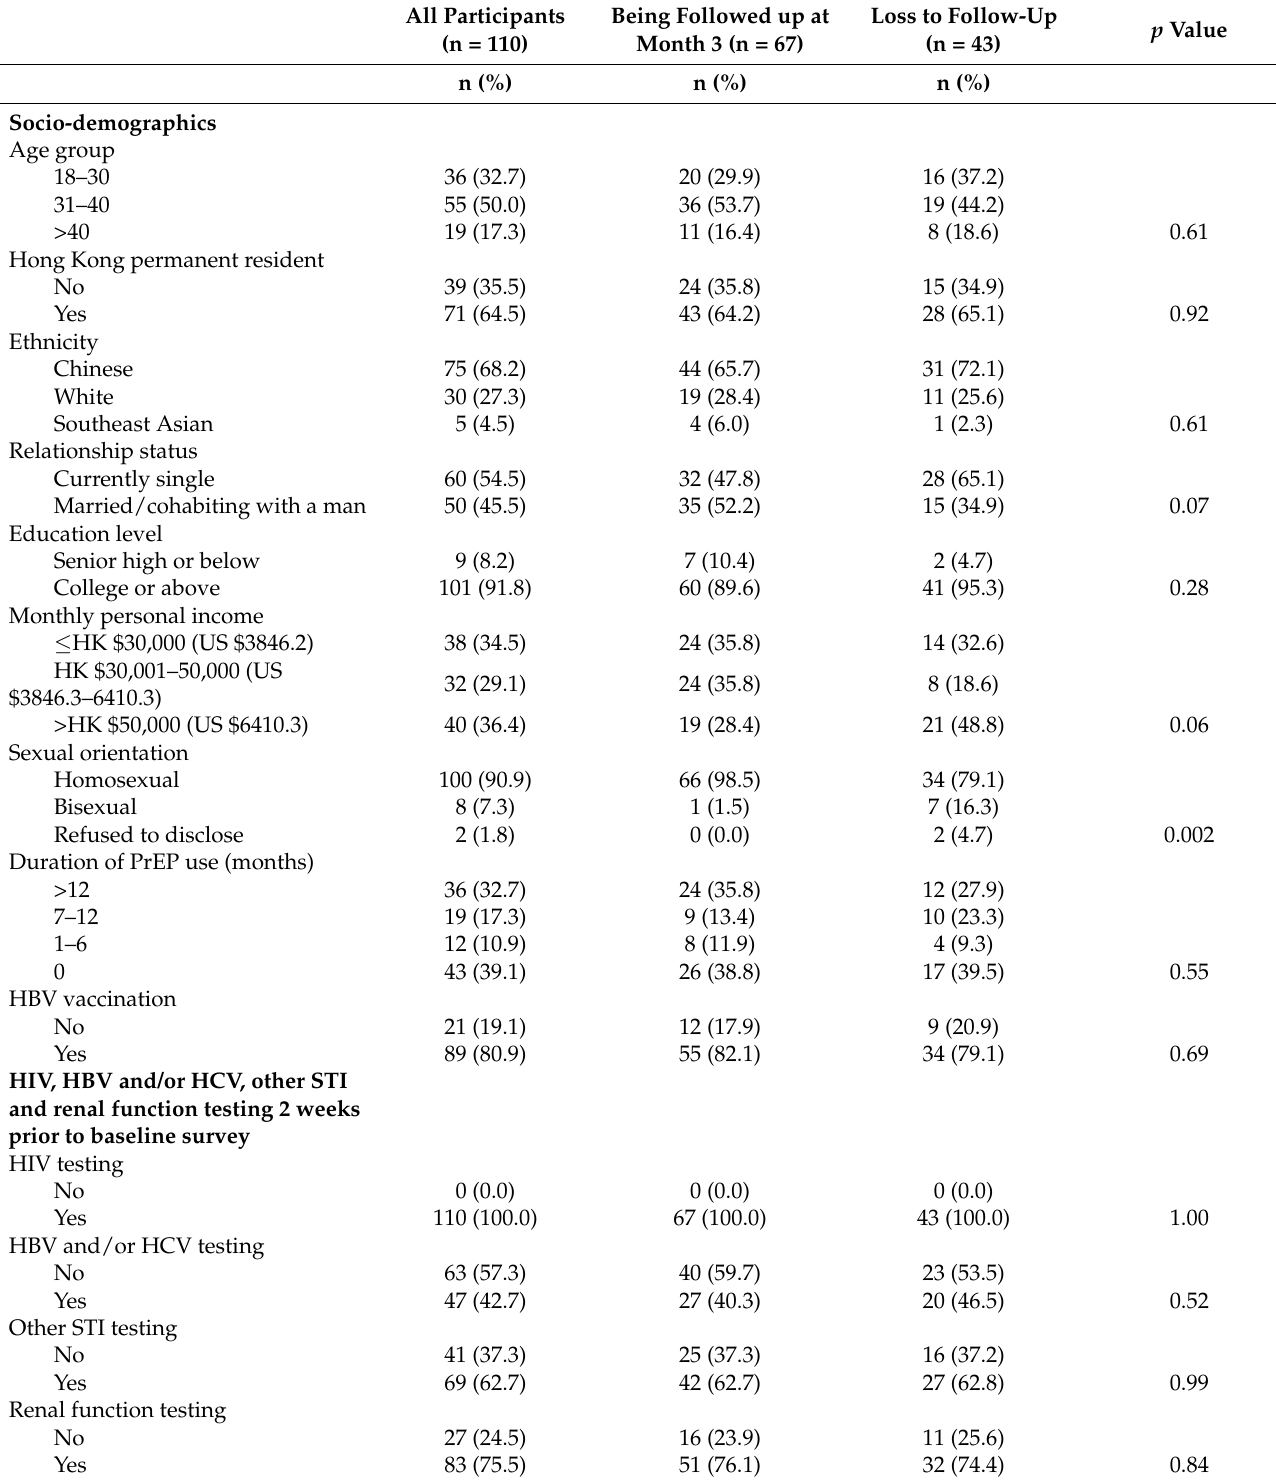
Table 1. Baseline characteristics of the